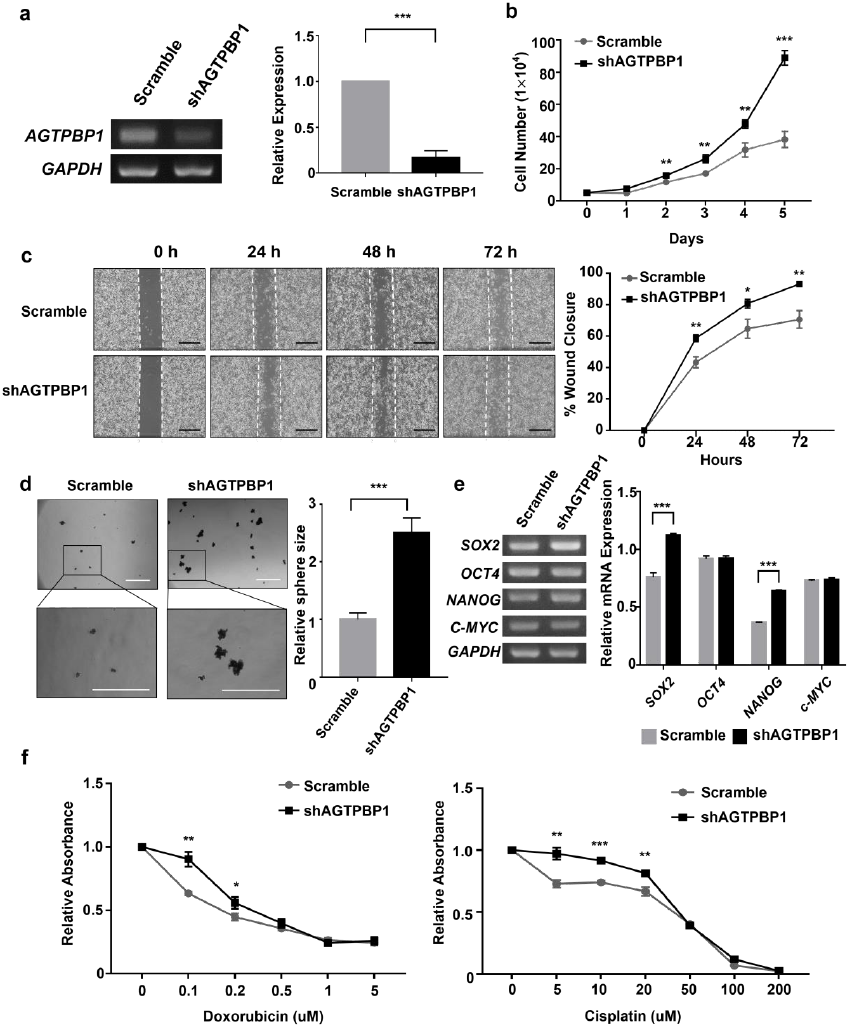
Figure 1. ATP/GTP binding protein 1 ( AGTPBP1 ) silencing in the A549 lung cancer cell line. ( a ) Relative expression of AGTPBP1 in shAGTPBP1-transduced and control cells was analyzed using Reverse transcription polymerase chain reaction (RT-PCR). Glyceraldehyde 3-phosphate dehydrogenase (GAPDH) was used as the loading control. ( b ) The number of AGTPBP1 -silenced cells and control cells was counted using a hemocytometer after trypan blue exclusion five days post transfection. ( c ) Cell migration analysis. The left panel represents wound closure of control and AGTPBP1 -silenced cells. The right panel represents the percentage of each wound closure at 24, 48, and 72 h after initiation of wound closure. ( d ) Sphere forming assay was performed using 6 well non-coated culture plates over a period of five days. Sphere size was measured using Image J and is shown as the relative size of spheres formed by AGTPBP1 -silenced cells, as compared to scramble cells. Scale bars correspond to 500 µ m. ( e ) Expression of stemness markers was measured using RT-PCR. Expression level of genes were adjusted to the expression of internal control GAPDH and shown as bar graph. ( f ) E ff ect of AGTPBP1 knockdown on drug resistance of A549 cells was visualized using Cell Counting Kit-8. The drugs used were doxorubicin and cisplatin. All values are expressed as mean ± standard deviation (SD) of at least three independent experiments, and statistical significance was analyzed using the two-tailed t -test. (*: p < 0.05; **: p < 0.01; ***: p <